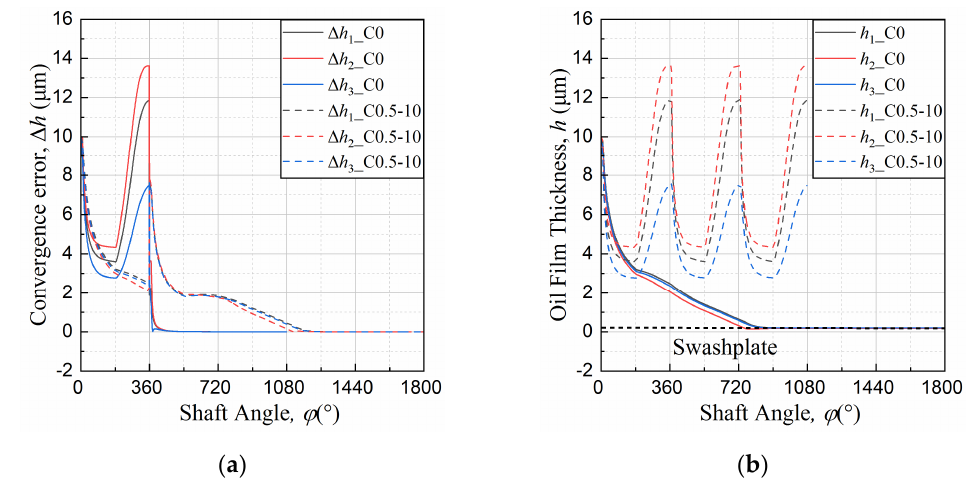
Figure 9. Convergence process of oil film thickness, where ( a ) is the convergence error; ( b ) is the oil film thickness. The pressure distribution of the slipper bottom at the main shaft angle of 90° in the